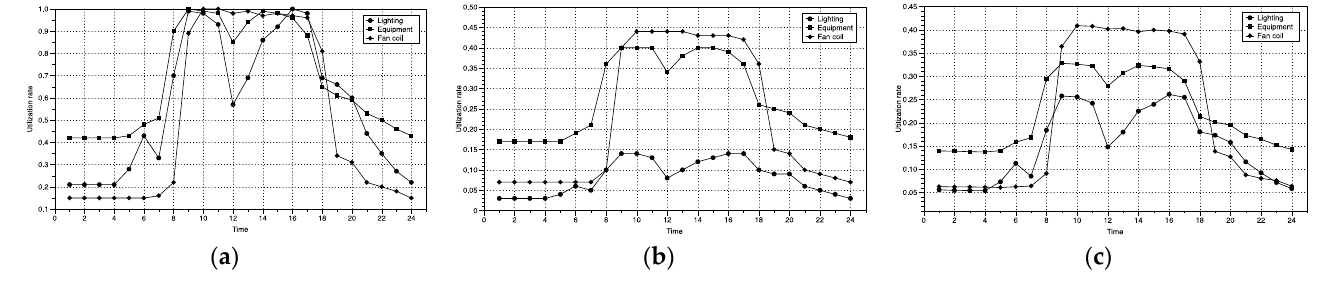
Figure 12. Runtime schedule: ( a ) Scenario 1; ( b ) Scenario 2; ( c ) Scenario 3.